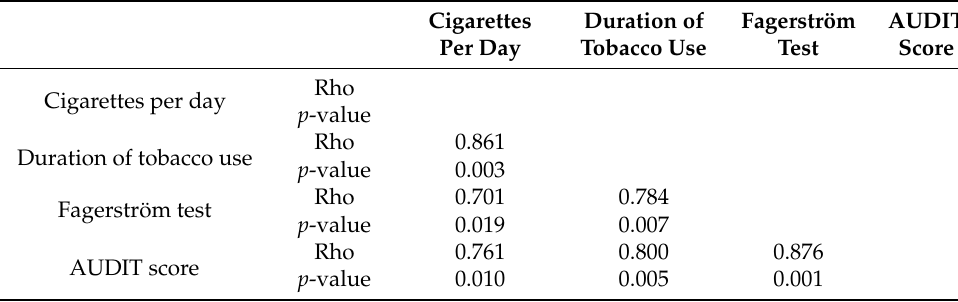
Table 4. Spearman’s correlation coefficient of early-stage